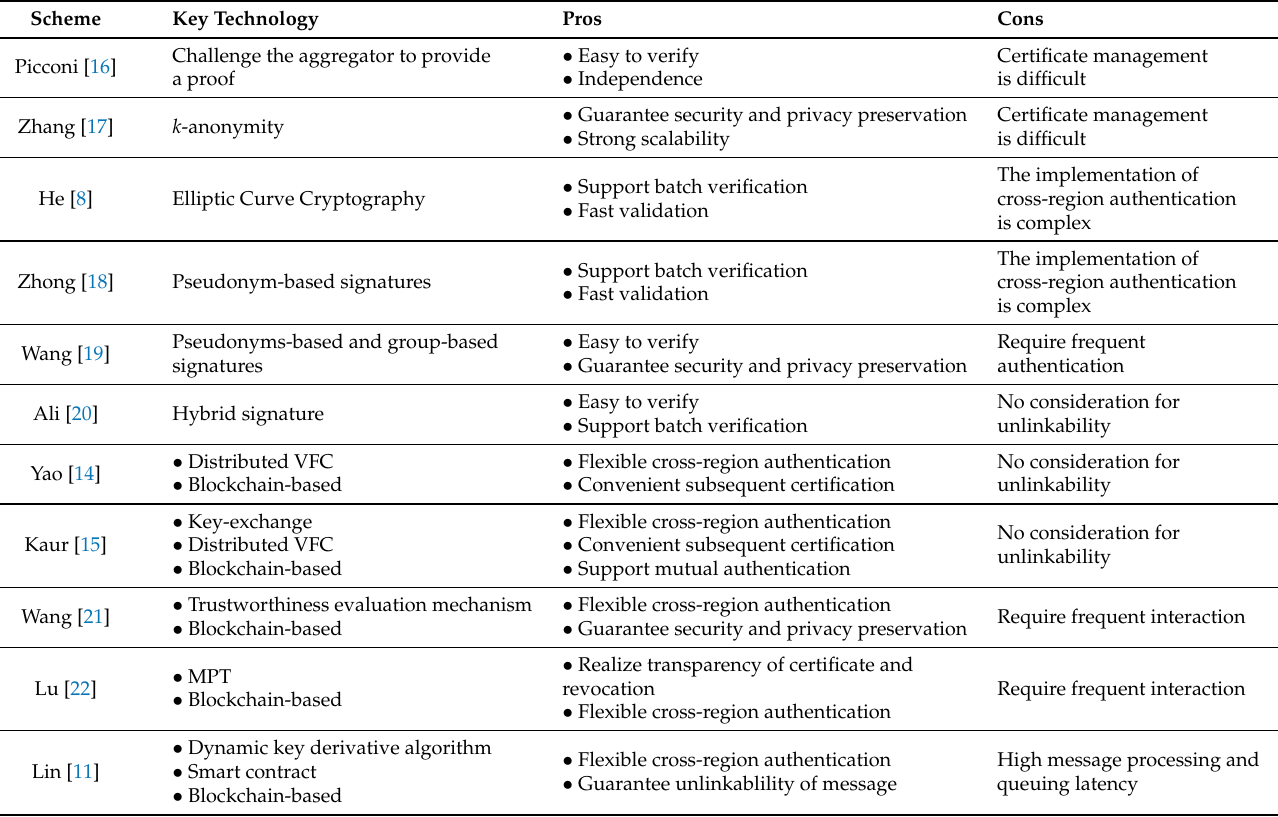
Table 1. Summary of related